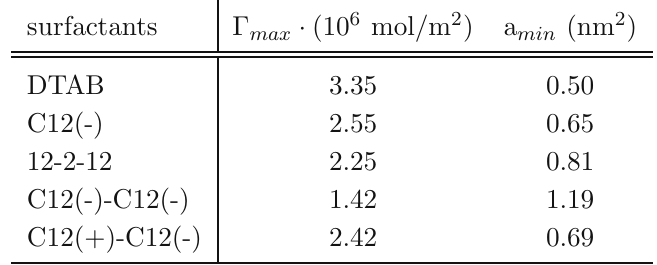
Table 5 The data of interface characters for